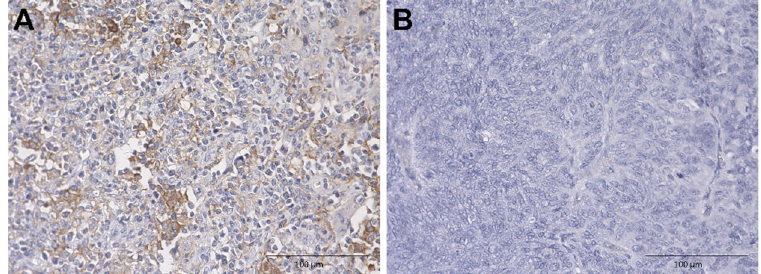
Figure 2. Membranous Programmed Death Ligand 1 (PD-L1) expression in upper tract urothelial carcinoma (UTUC) tissue microarray specimens. ( A ) UTUC tissue with moderate expression. ( B ) UTUC tissue with negative expression.